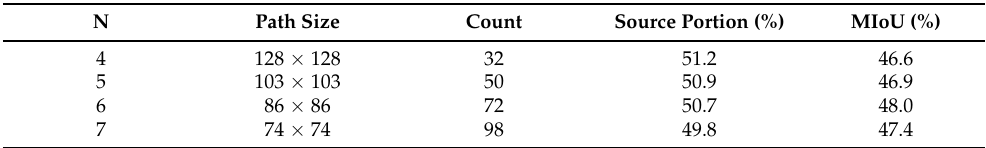
Table 4. Parameter study of patch partition on GTA5 → cityscapes adaptative semantic segmenta- tion